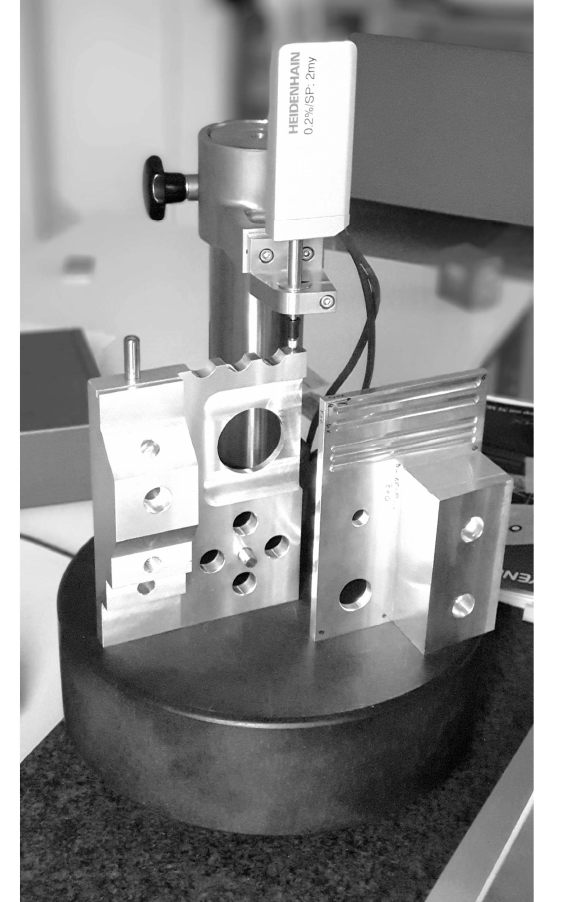
Figure 6. The reference workpiece (left) and the workpiece (right) and the length gauge in example